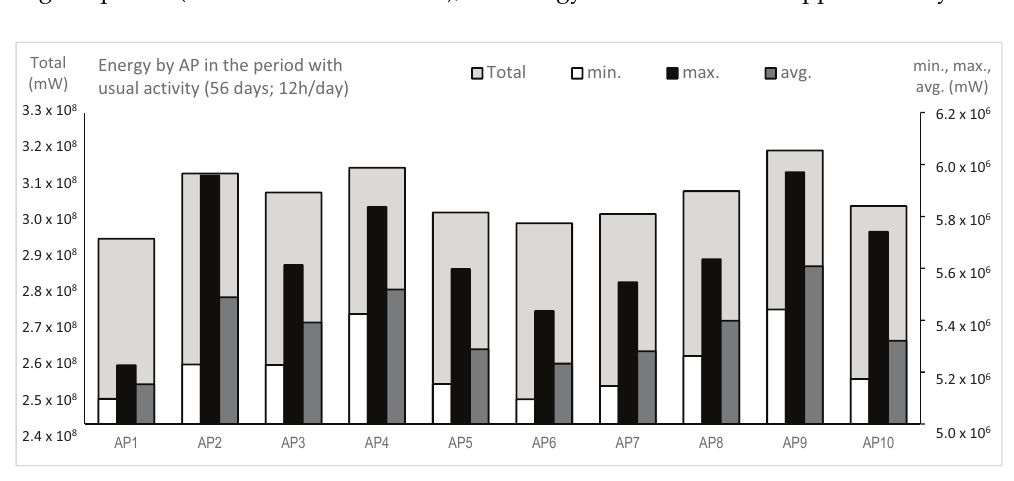
Figure 4. Minimum, maximum, average and total energy in each AP, considering the valid period (56 days with users’ activity) and the usual time slot (9:00 to